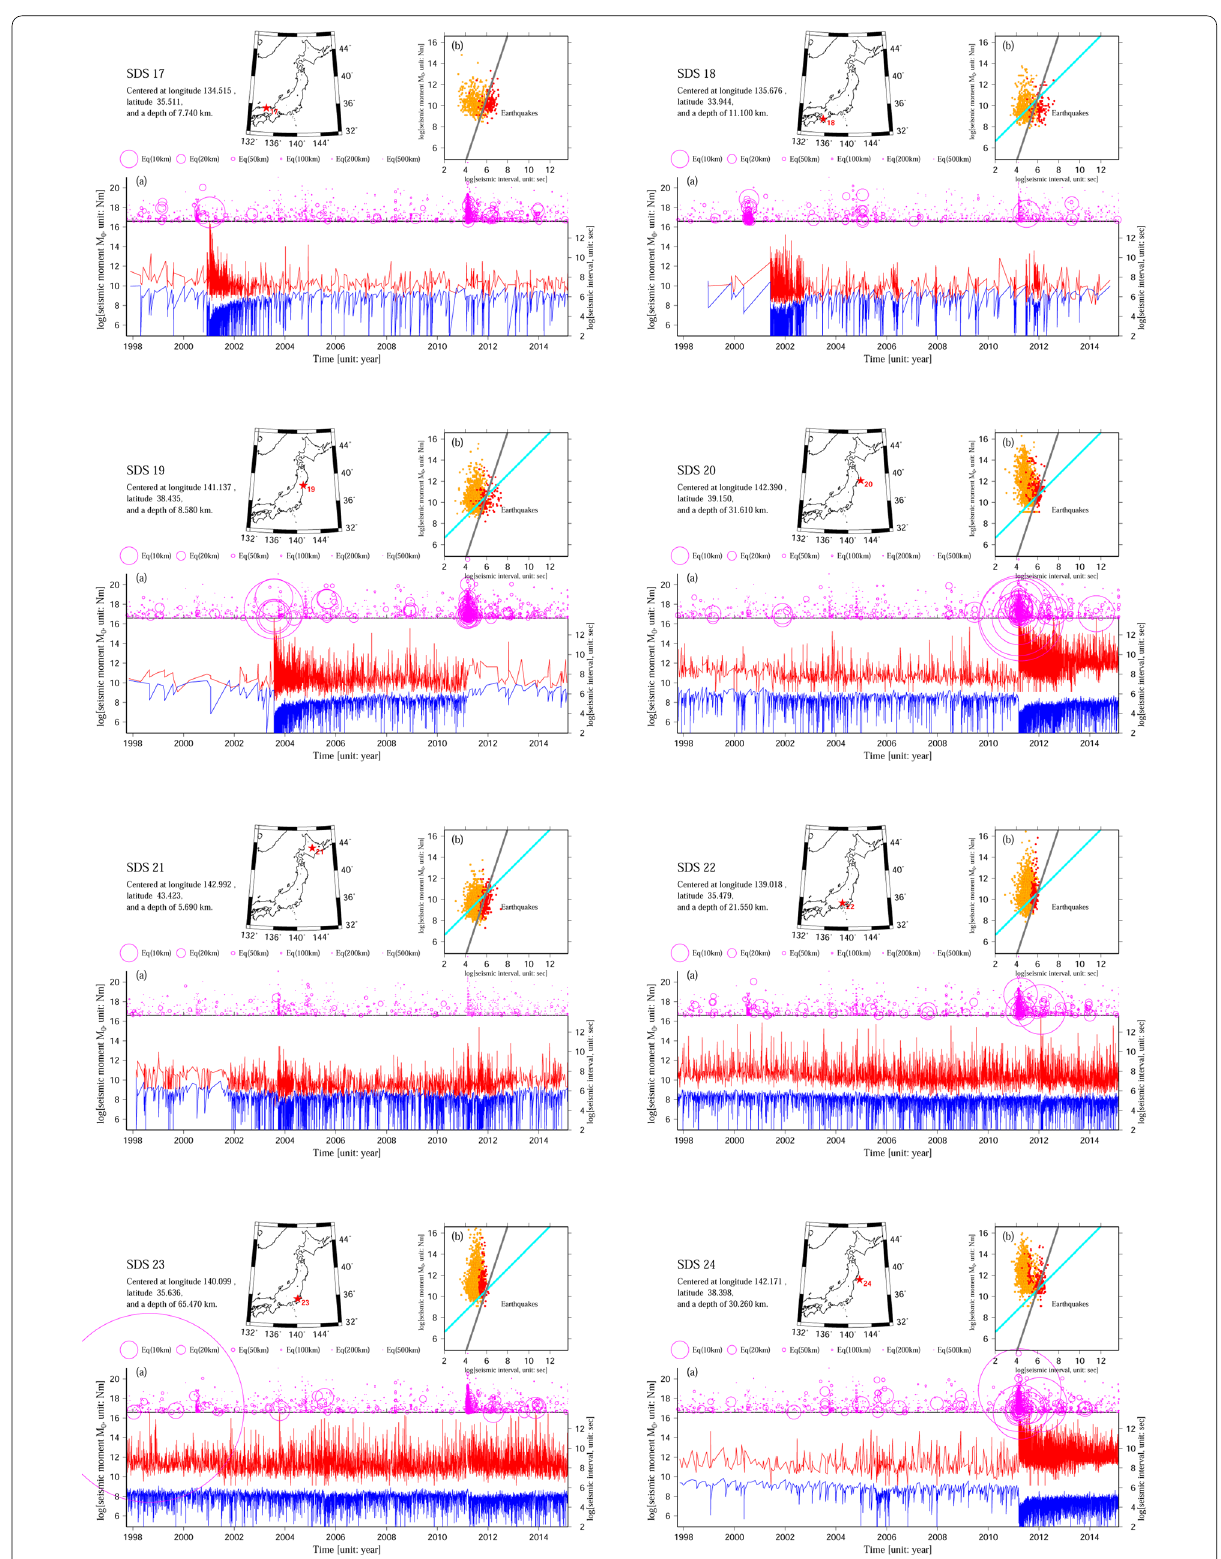
Fig. 5 Calculated results of seismic moment and seismic interval at the selected regions of seismicity density spheres